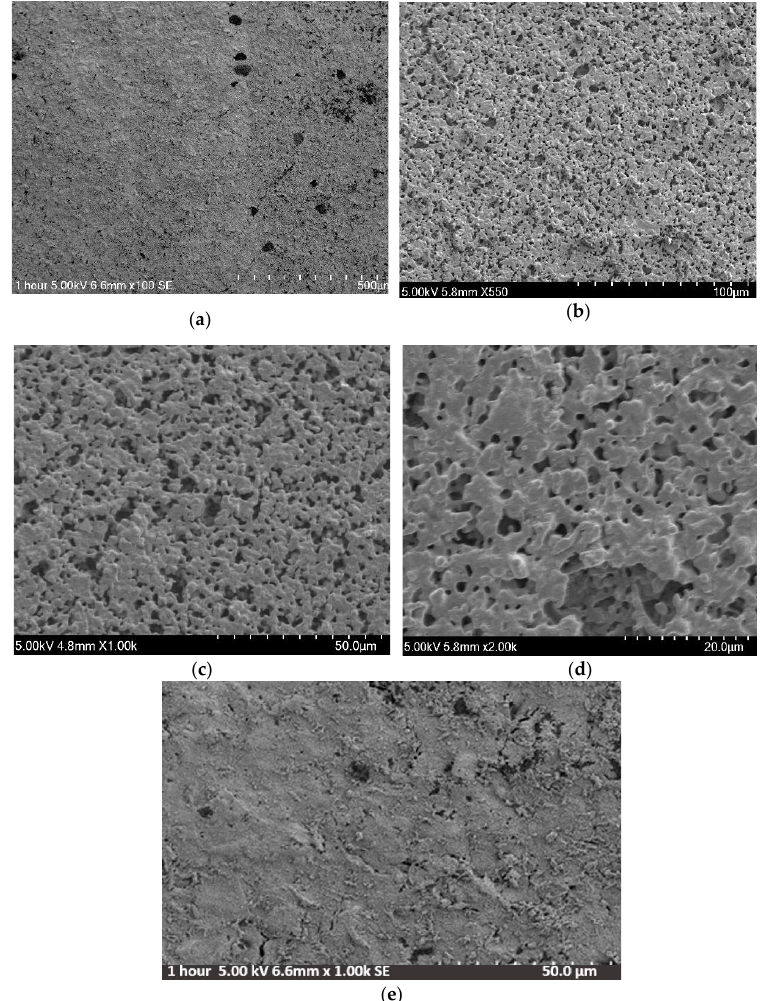
Figure 4. SEM secondary electron images taken with Hitachi SU3500 of ( a – d ) 85 nm TiN sensor modified with Nafion film at various magnifications, and ( e ) unmodified 85nm TiN sensor [45].